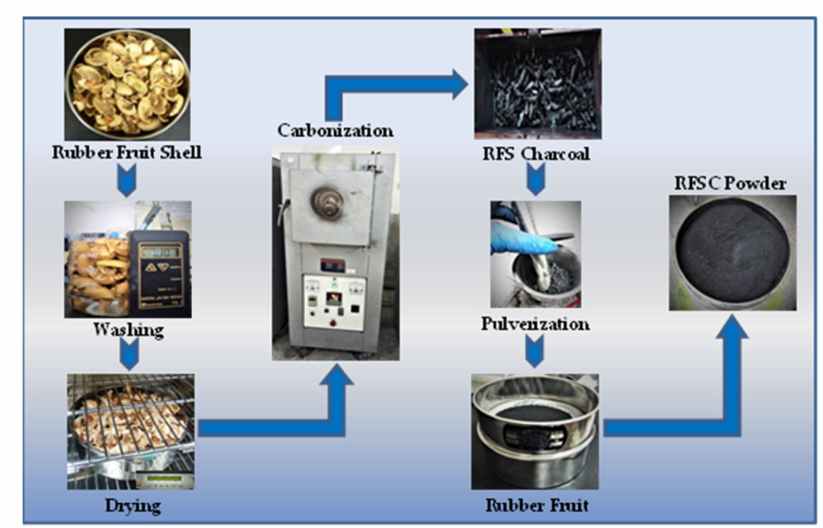
Figure 1. The rubber fruit shell charcoal (RFSC) powder manufacturing process